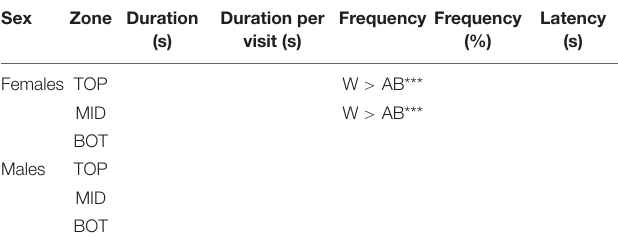
TABLE 2 | Pairwise comparisons between strains and sexes in the zones of the novel tank diving test (NTDT) in AB and wild (W) zebrafish, separating males and